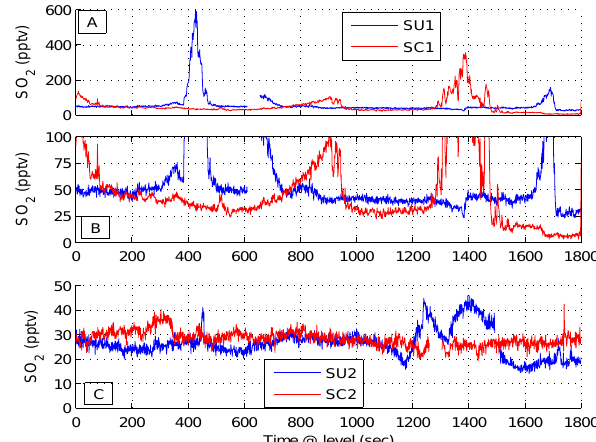
Fig. 1. SO 2 (1Hz) time series for CBL circles of RICO RF14. Panel (B) shows an expanded scale of (A) . Times are relative to the start times of circles given in Table 1. The SO 2 peak near 1400 s of SC1 is not the same one as the peak in near 450 s of SU1, which was 40km downwind at the time of the peak in SC1.